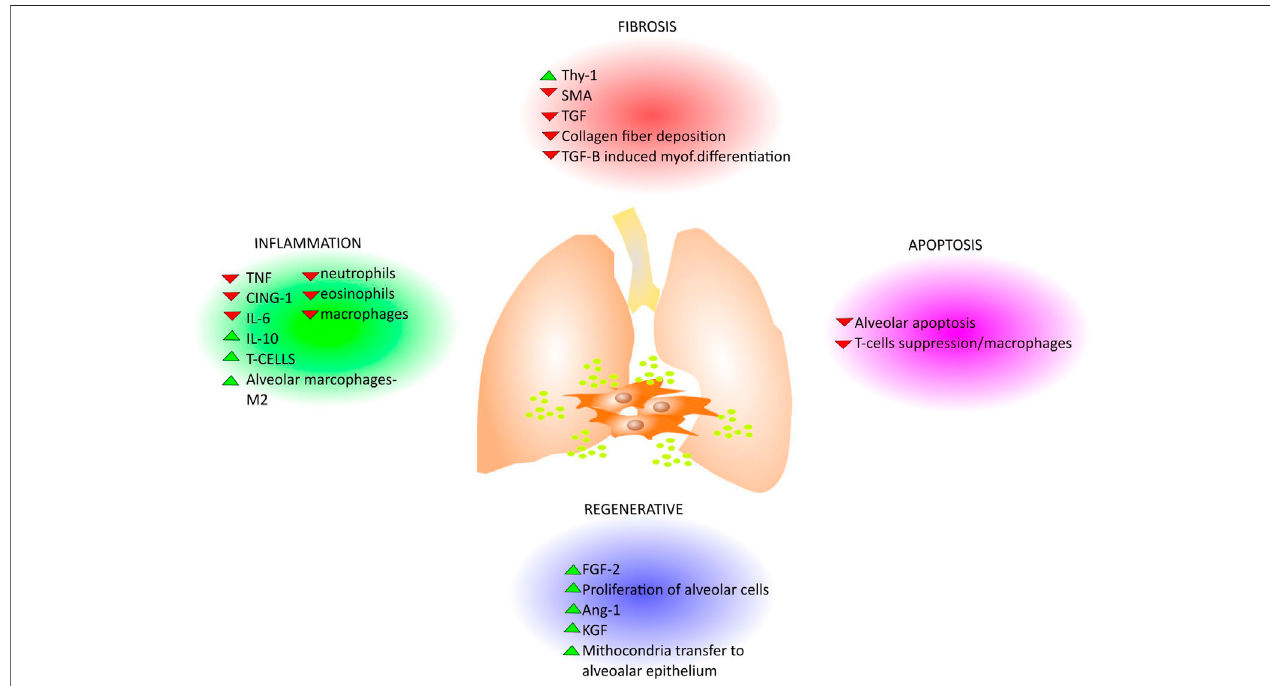
FIGURE3| ParacrineeffectsofMSCsinlungdisease.SincetheMSCsderivedEVsplaypivotalrolesindifferentpathwaysthatarecommoninlungdisease,several worksdescribetheeffectoftheiradministrationforlungdiseasestreatment.Ingeneral,theMSCsderivedEVsdisplayanti fi brotic,antiapoptotic,anti-in fl ammatoryeffects and counteract fi brosis with different mechanisms where they can either enhance (green head-arrow) or down-regulate (red head-arrow) growth factors and cytokines secretion as well as functional activity in lungs (e.g., collagen deposition, mitochondria transfer, etc) as summarized in the cartoon.